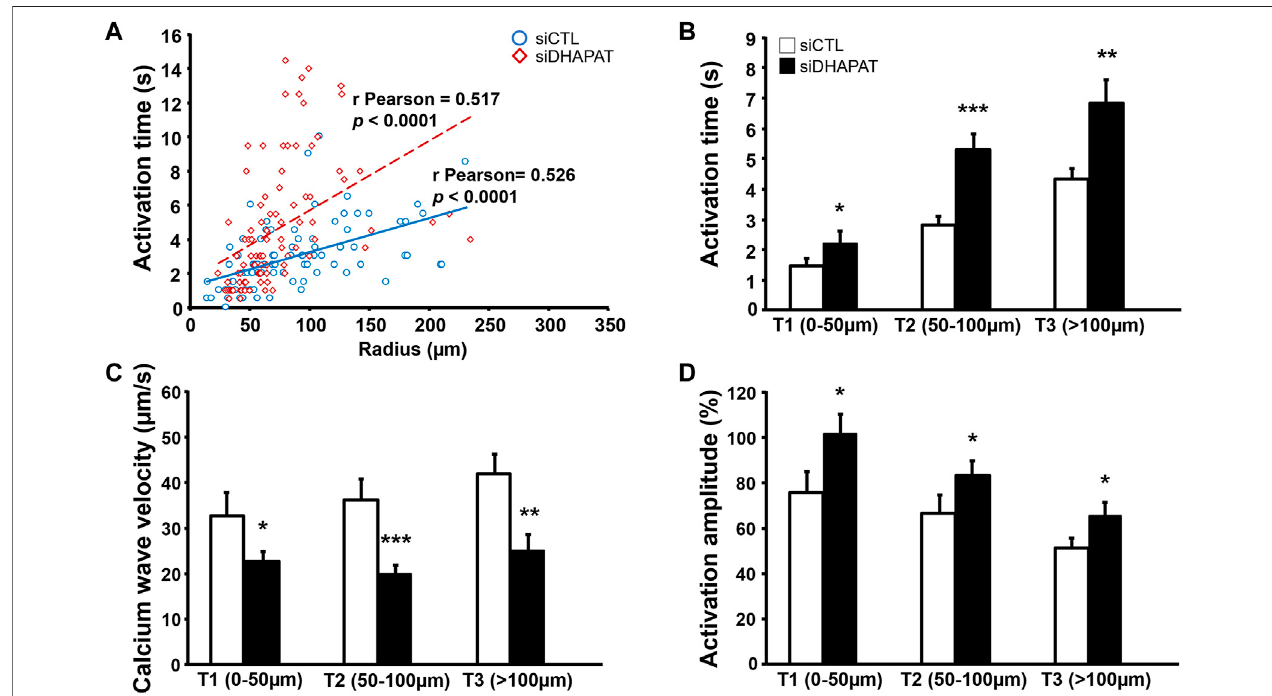
FIGURE 8 | GJIC alterations in astrocytes neighboring plasmalogen-depleted Müller cells. (A,B) Astrocytes stimulated by plasmalogen-depleted Müller cells display a signi fi cant increase in the activation time (A,B) and amplitude (D) , as well as in calcium wave velocity in all tertiles of distance (C) . n ≥ 75 astrocytes. Student t test. * p < 0.05; ** p < 0.01; *** p < 0.001. Data shown as mean ±